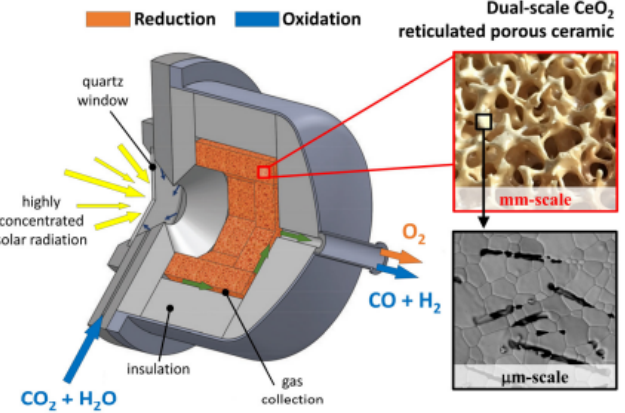
Figure 9. Sun-to-liquid solar reactor configuration using ceria reticulous porous ceramic structures [92].